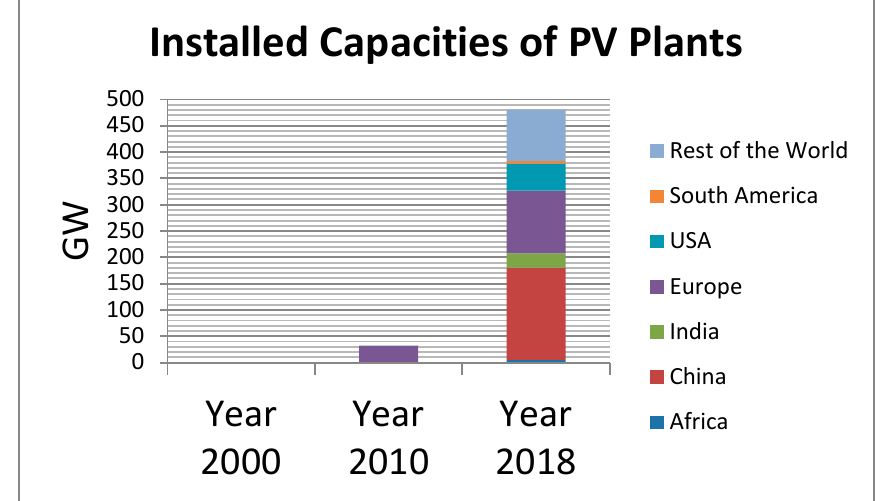
Figure 2. Installed PV capacities for selected countries and regions [26].